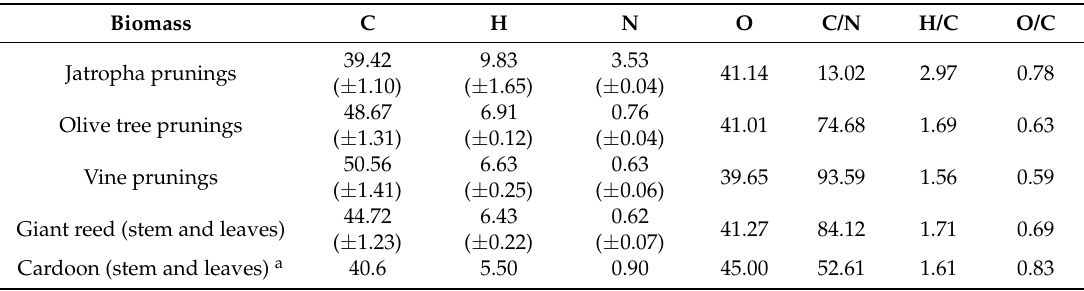
Table 1. Elemental analysis (db, % w/w ) of jatropha wood in comparison with other biomasses (figures in parentheses are standard